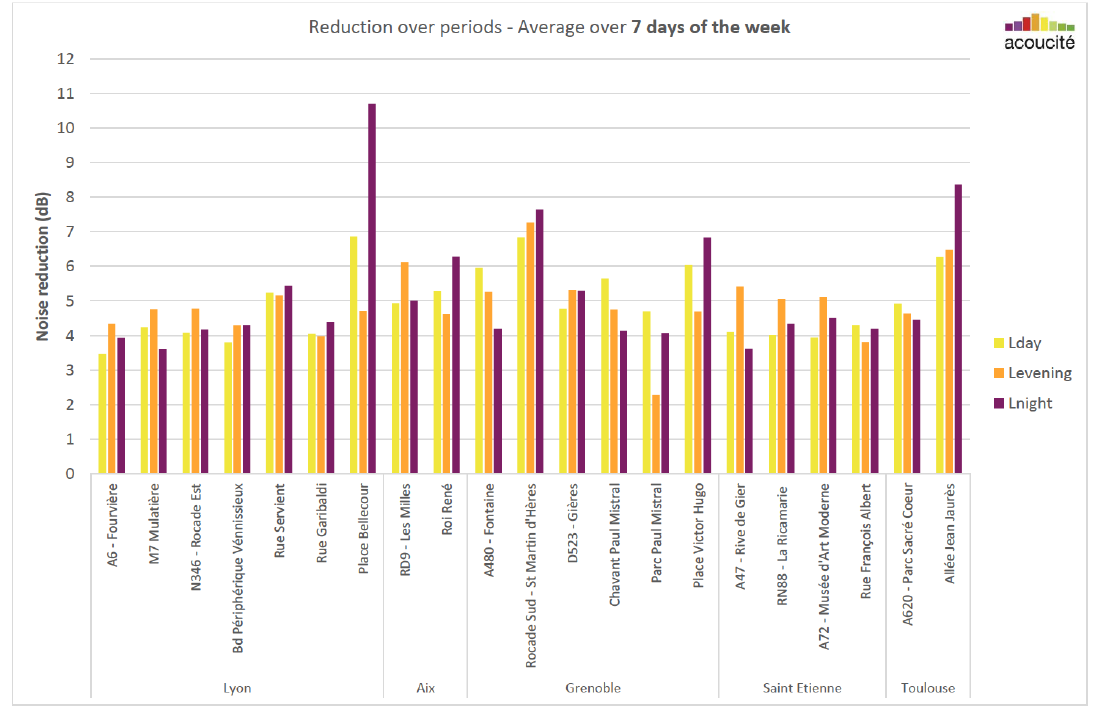
Figure 5: Reduction observed by period of the day for the 21 measuring stations. Difference between the average sound level in “normal situation” and the average sound level during